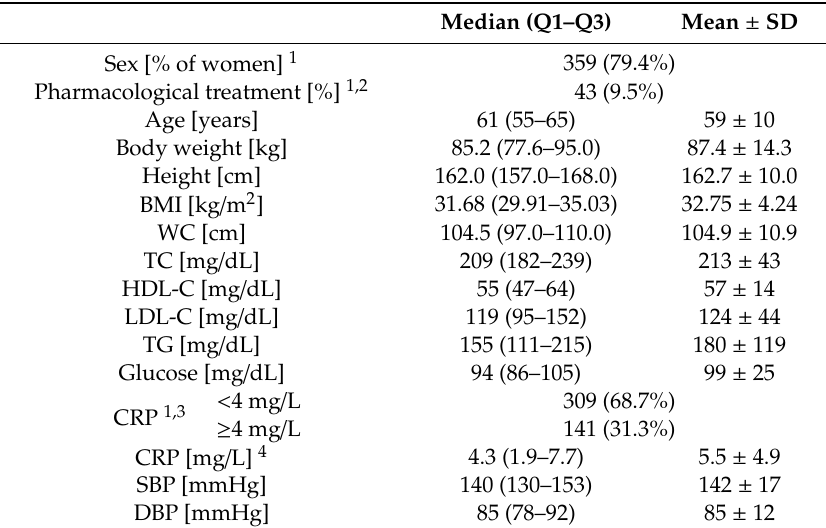
Table 1. Characteristics of the study population ( n = 452).